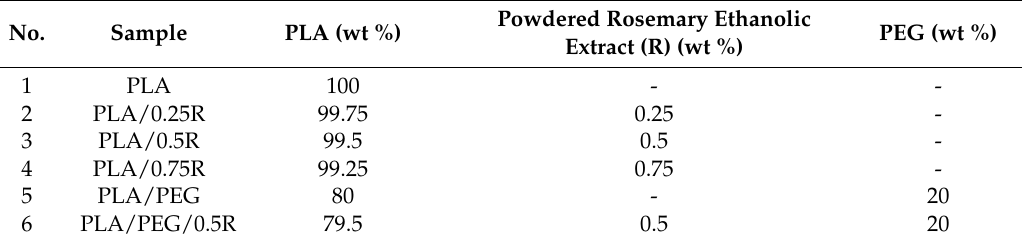
Table 1. Compositions of the prepared poly(lactic acid) (PLA)-based